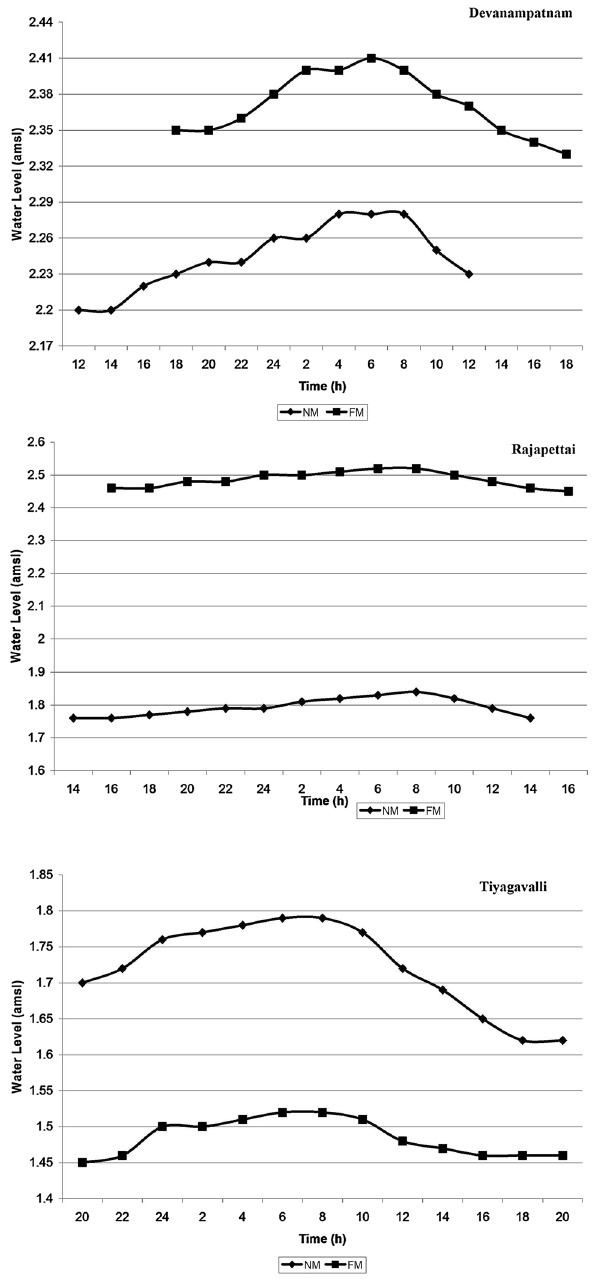
Fig. 2 Water level fluctuations during FM and NM at Devanampat- nam, Rajapettai and Tiyagavalli (all values in amsl)